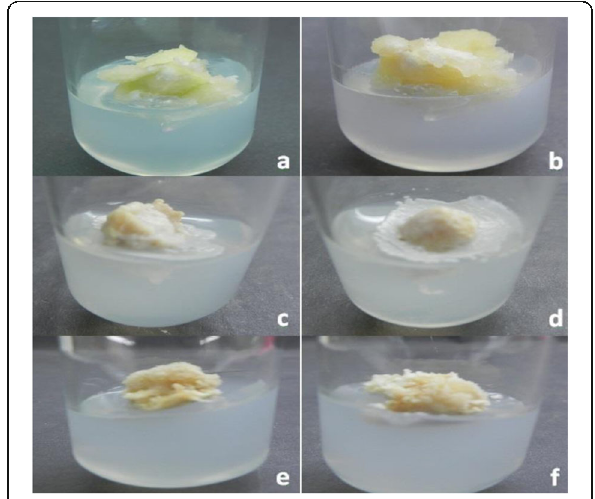
Fig. 1 Calli infected with Agrobacterium and washed with antibiotic. a calli induced from Citrus reticulata Blanco; b calli induced from Citrus sinensis (L.) Osbeck; c infected calli of Citrus reticulata Blanco; d infected calli of Citrus sinensis (L.) Osbeck; e : antibiotic-treated calli of Citrus reticulata Blanco, and f antibiotic-treated calli of Citrus sinensis (L.) Osbeck